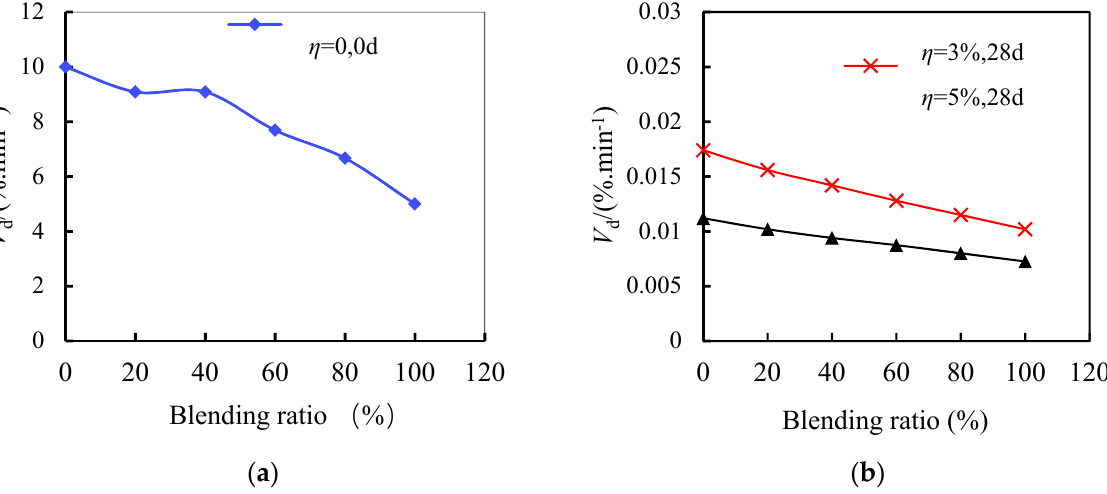
Figure 10. Disintegration rate vs blending ratio of red clay with different cement mixing ratio ( a ) η = 0; ( b ) η = 3% and η = 5%.